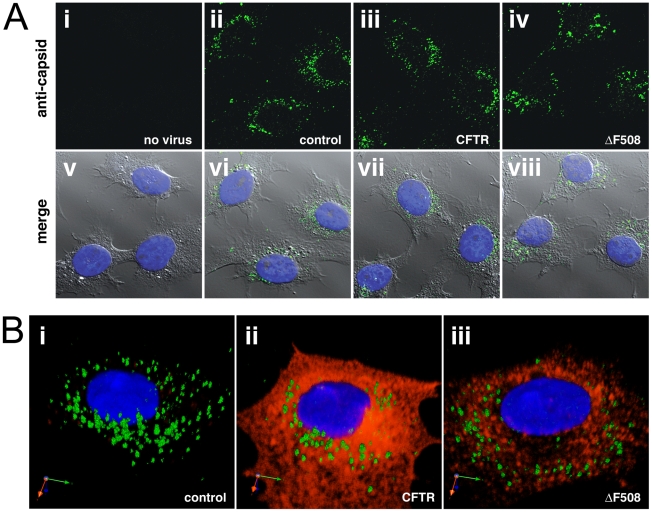
Perinuclear accumulation of AAV capsids in control, CFTR, or ΔF508-CFTR cells.A. Confocal immunofluorescence staining of capsids (green) 16 hr post-inoculation (50,000 vg/cell) do not demonstrate obvious differences in subcellular trafficking at this level of resolution. B. Single cell 3D composites were rendered using volume imaging software on z-stacked images taken after co-staining virus capsids with CFTR (panel ii, red) or ΔF508-CFTR (iii, red). Absence of yellow color suggests no direct interaction between AAV and wt or mutant CFTR, yet does not rule out that they could be degraded or processed through the same pathway. Nuclei (blue) were stained with DAPI.